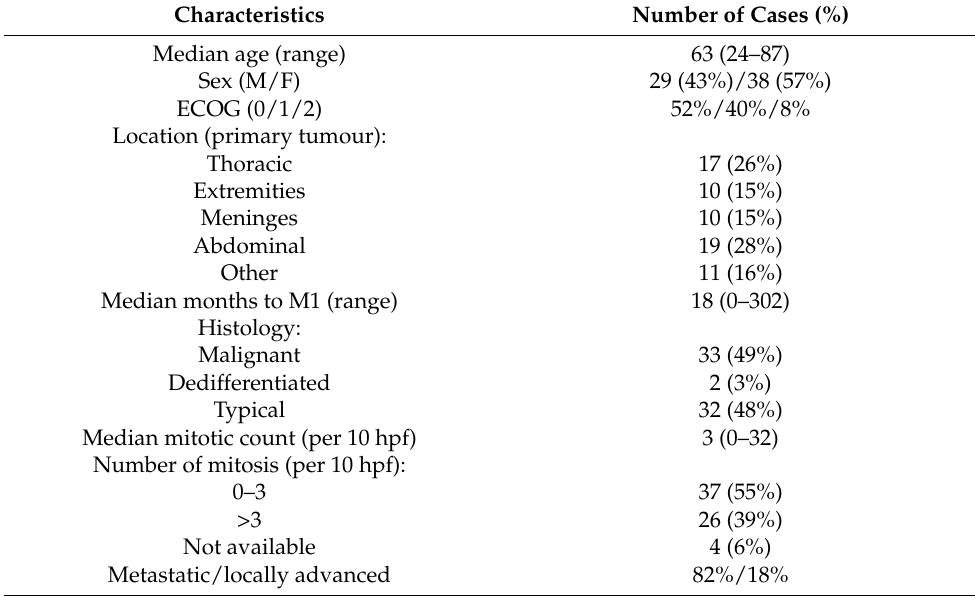
Table 1. Clinicopathologic characteristics of accrued